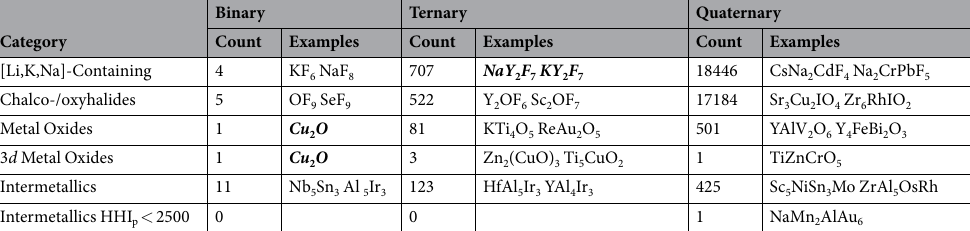
Table 2. Subset of Potential Stable Compounds Predicted using ElemNet . Out of the 450 M predictions, we determined the number of systems where ElemNet identifies at least one new potential stable compound. We list the number of binary, ternary, and quaternary systems for several categories of compounds along with the two most stable predictions. We validated some of the these compounds- NaY 2 F 7 and KY 2 F 7 using DFT computations by leveraging crystal structures of existing materials with similar stoi-chemistry; we found them to be stable using DFT, further literature search revealed that they have already been synthesized recently. Our model predicts Cu 2 O as the only new binary oxide which is a known compound but was not in our training